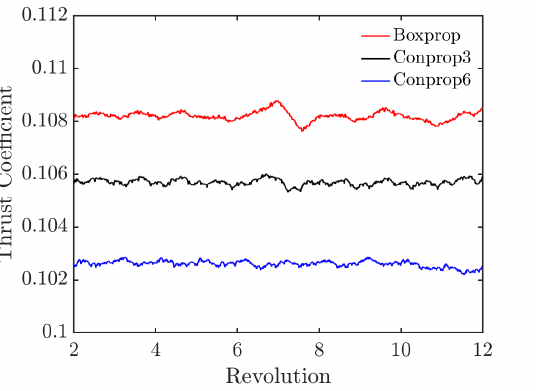
Figure 10. The transient thrust coefficients with respect to the normalized physical time in